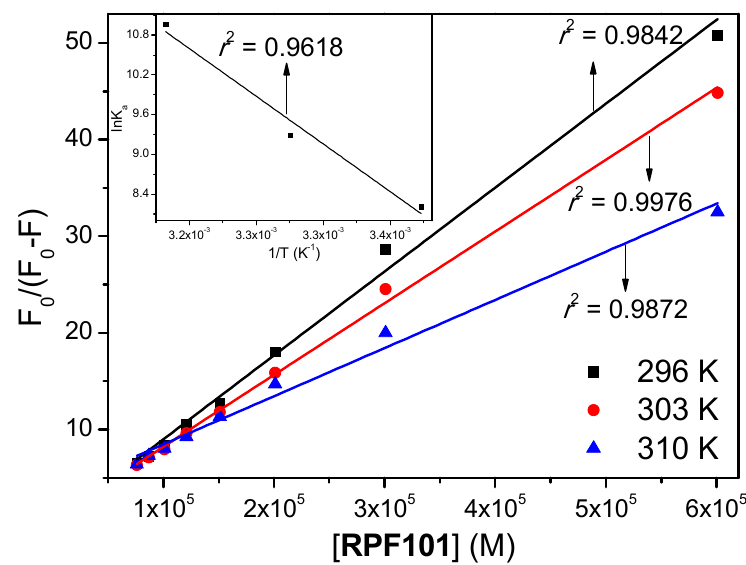
Figure 4. Modified Stern-Volmer plots for the association HSA: RPF101 in PBS solution at 296, 303 and 310 K. Inset : Van’t Hoff plot for HSA: RPF101 at three different temperatures. [HSA] = 1.00 × 10 − 5 M and [ RPF101 ] = 0.17; 0.33; 0.50; 0.66; 0.83; 0.99; 1.15; 1.32 × 10 − 5 M. Table 1. Stern-Volmer quenching constant ( K SV ), bimolecular quenching rate constant ( k q ), modified Stern-Volmer binding constant ( K a ) and thermodynamic parameters ( Δ H °, Δ S °, and Δ G °) for HSA: RPF101 at 296, 303, and 310 K a .